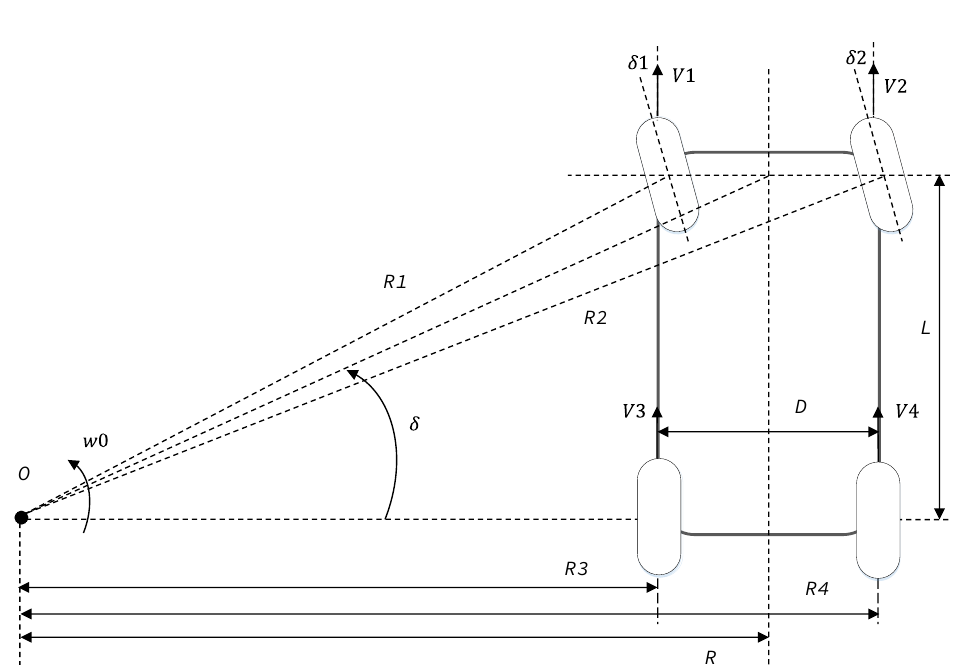
Figure 2. Kinematic model of proposed system in left turning maneuver.